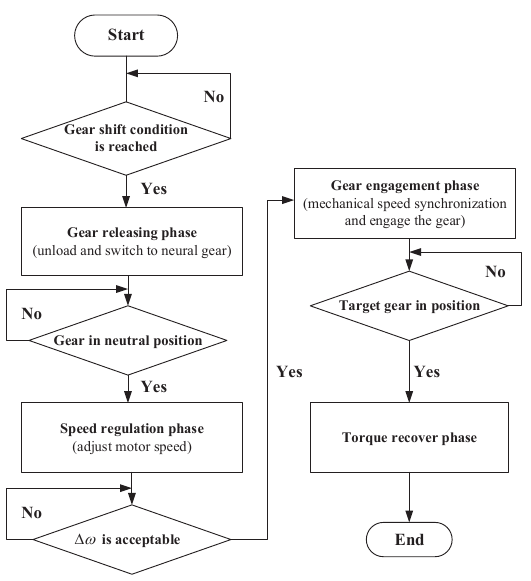
Figure 3. The gear shift process flowchart of the hybrid DCT in pure electric drive